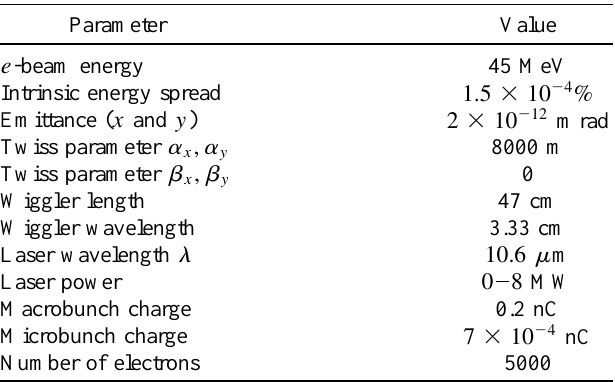
TABLE IV. Parameters for the IFEL modeling code and PARMELA